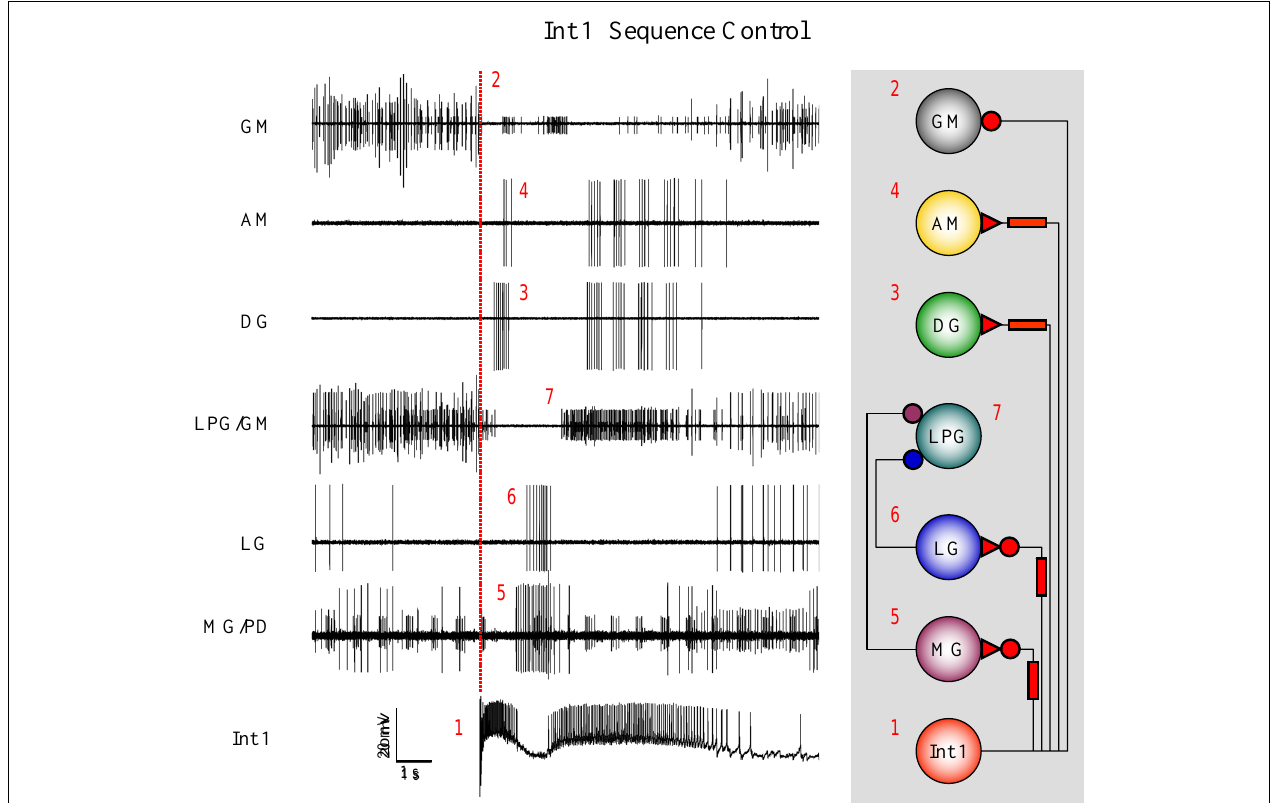
FIGURE 13 | Post-inhibitory rebound following steady hyperpolarization of the Int 1 neuron sets up a cascade of events that illustrate how the fi ring sequence for the entire gastric network is established. The start of the Int 1 burst (1) at the vertical red line immediately terminates GM activity (2) which can be seen both in the GM and LPG/GM traces. This is followed by a delayed